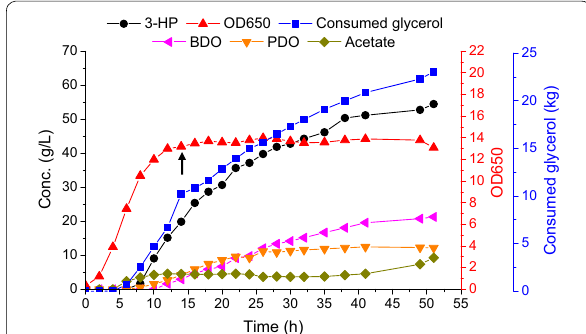
Fig. 3 The profiles of cell density, 3-HP and other metabolites by strain JJQ02(pUC18- kan - aldH ) in fed-batch fermentation in a 5-L bioreactor. OD 650 (back down-pointing triangle); 3-HP (black circle); PDO: 1,3-propanediol (back down-pointing triangle); BDO 2,3-butanediol (back left-pointing triangle); acetate (black diamond); the black arrow represents the time point to lower the aeration rate